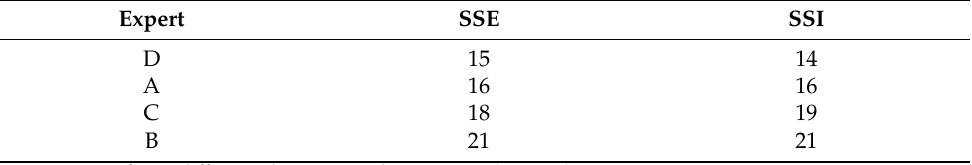
Table 7. Results of the Simple Ranking test applied to ordinal data matrices obtained by assigning rank order number to experts according to their (a) contributions to the sum of squares of the error (SSE) and (b) contribution to the sum of squares of the interaction expert x sample (SSI). Expert SSE SSI D 15 14 A 16 16 C 18 B 21